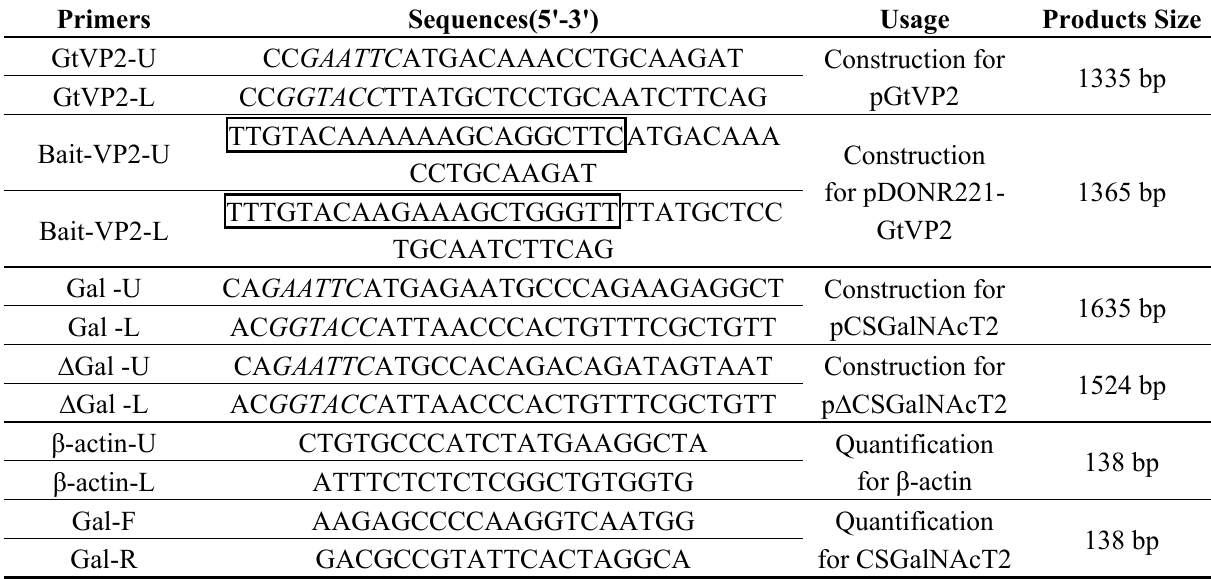
Table 1. Primers used in this